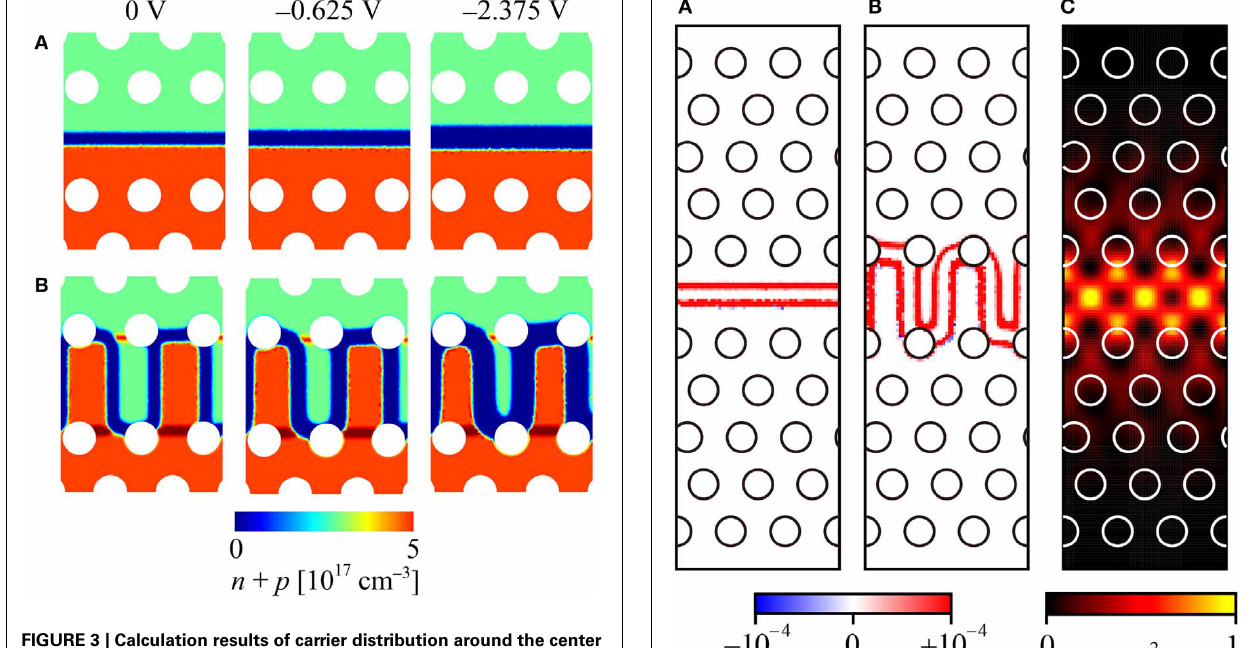
FIGURE 3 | Calculation results of carrier distribution around the center of LSPCW (model I of Figure 2). (A) Device #1 with linear junction. (B) Device #2 with interleaved junction. Blue region shows depletion region.